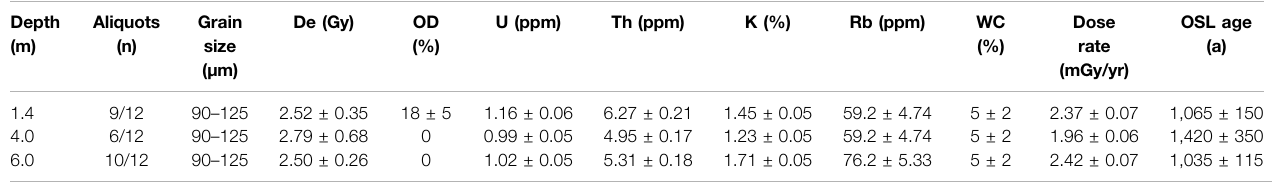
TABLE2| Quartzopticallystimulatedluminescence(OSL)resultsatdifferentdepths,includingequivalentdose(De),overdispersion(OD),contentsofU,Th,K,Rb,andwater content (WC), dose rate, and quartz OSL ages. Depth Aliquots (m)